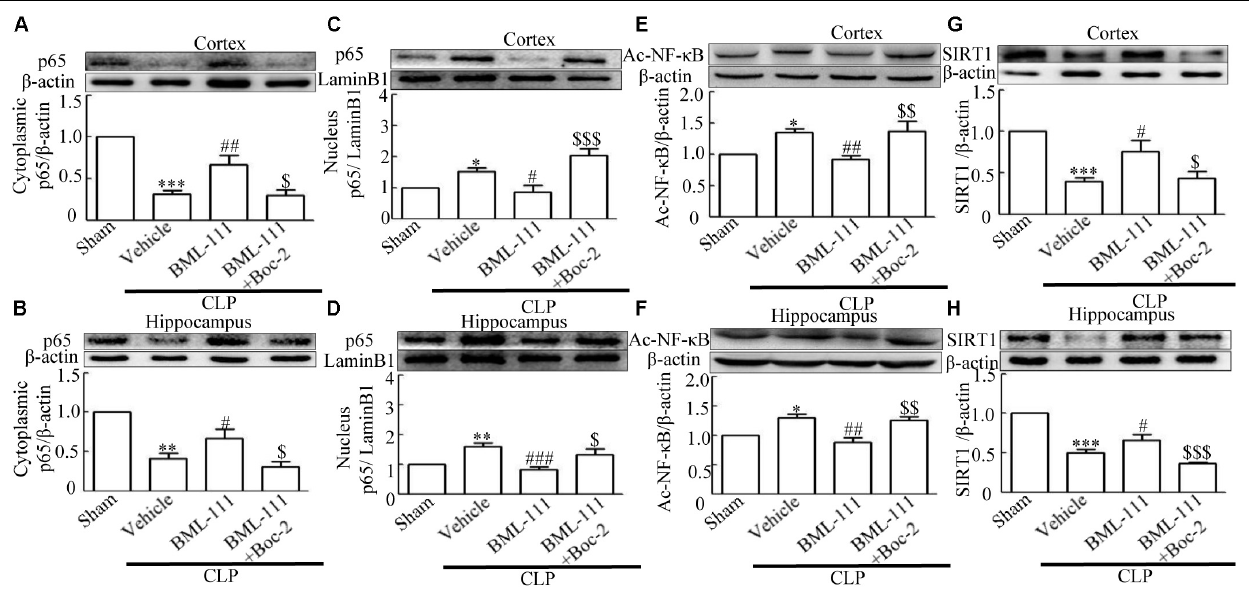
FIGURE 8 | BML-111 treatment significantly inhibits NF- κ B and increases the expression of SIRT1. (A,B) Sepsis significantly reduced the expression levels of cytoplasmic p65 in the cortex and hippocampus relative to the sham group. BML-111 increased the expression of cytoplasmic p65 compared with the CLP + vehicle group, and Boc-2 reduced the effects of BML-111. (C,D) Nuclear p65 was up-regulated after CLP when compared with the sham group. BML-111 reversed the change in nuclear p65 level, and Boc-2 reduced the effects of BML-111. (E,F) Ac- NF- κ B was increased in CLP group compared with sham group, BML-111 decreased the level of Ac- NF- κ B than in CLP + Vehicle group, and Boc-2 reduced the effect of BML-111. (G,H) Sepsis significantly reduced the expression levels of SIRT1 in the cortex and hippocampus when compared with the sham group. BML-111 recovered the expression of SIRT1 compared with the CLP + vehicle group, and Boc-2 reduced the effects of BML-111. Data were shown as the means ± SEM ( n = 3 surviving mice in A , n = 4 surviving mice in B , n = 5 surviving mice in C , n = 6 surviving mice in D , n = 3 surviving mice in E,F , n = 5 surviving mice in G , n = 6 surviving mice in H ). ∗ P < 0.05, ∗∗ P < 0.01, ∗∗∗ P < 0.001 represent CLP + Vehicle vs. Sham, # P < 0.01, ## P < 0.01, ### P < 0.001 represent CLP + BML-111 vs. CLP + Vehicle, $ P < 0.05, $$ P < 0.01, $$$ P < 0.01 represent CLP + BML-111 + Boc-2 vs.